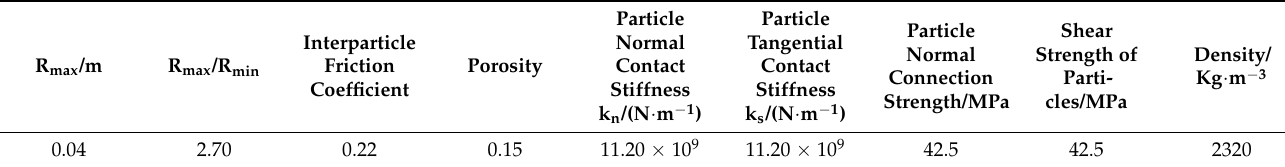
Table 1. Reservoir particles micromechanics parameters.